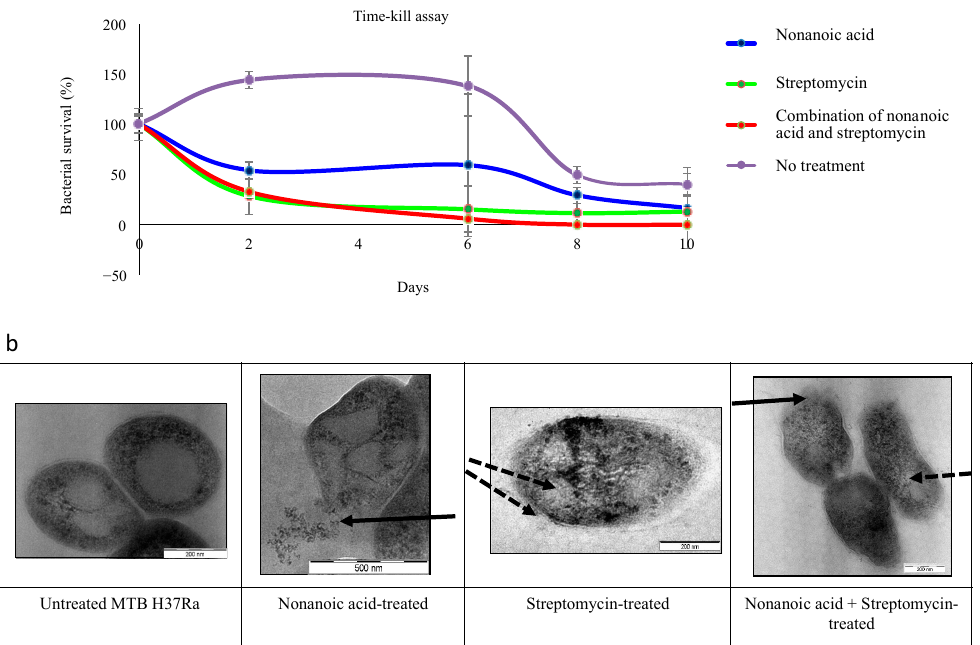
Figure 2. ( a ) Time–kill assay of Mycobacterium tuberculosis (MTB) H37Ra treated with nonanoic acid (50 µg/mL) and streptomycin (1.56 µg/mL). A total of 99% of bacterial cells were killed by a combination of nonanoic acid and streptomycin (red line) compared to 87% by streptomycin alone on Day 7. Each treatment condition contained 0.5 mL inoculum per 5 mL culture, and incubated at 37 ◦ C in 4% CO 2 with swirling for 10 days, and periodically sampled for plate counting; ( b ) Cross-sectional view of MTB H37Ra under a transmission electron microscope (TEM). TEM images show cross-sectional cell wall damage and cellular leakage of nonanoic acid-treated cells (12,500 × magnification) and streptomycin-treated cells (25,000 × magnification); nonanoic acid- and streptomycin-treated cells (20,000 × magnification) compared to untreated cells (10,000 × magnification). Notes: Treatments in the time-kill assay are based on their respective MIC values. Solid arrows indicate leakage of cellular components and dashed arrows indicate damaged cellular components and cell